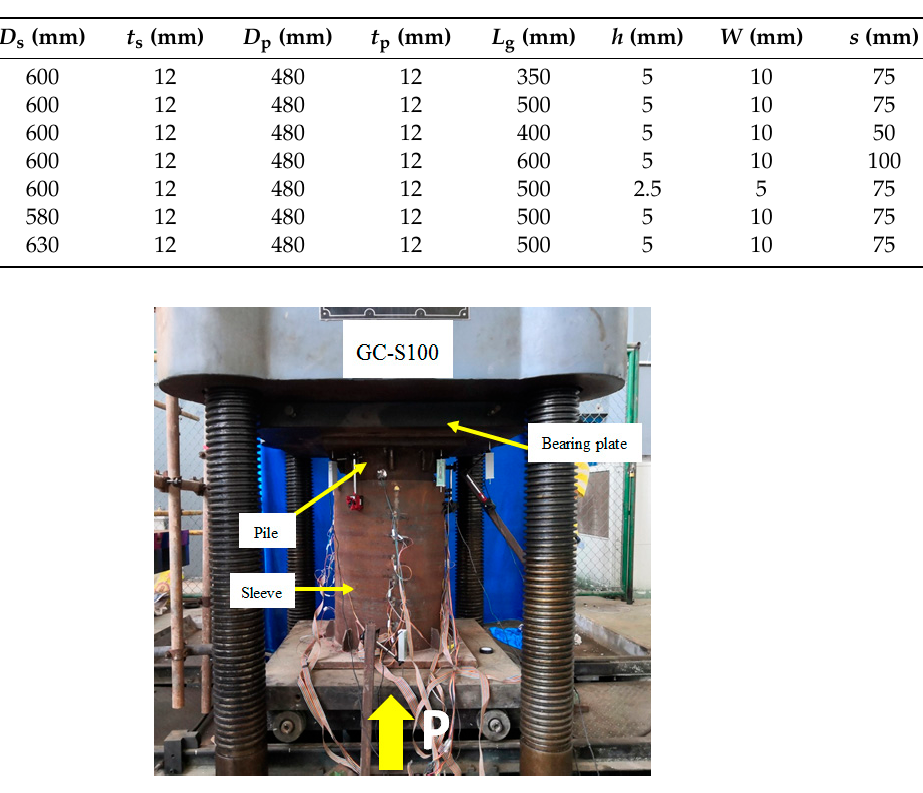
Table 3. Dimensions of test specimens.